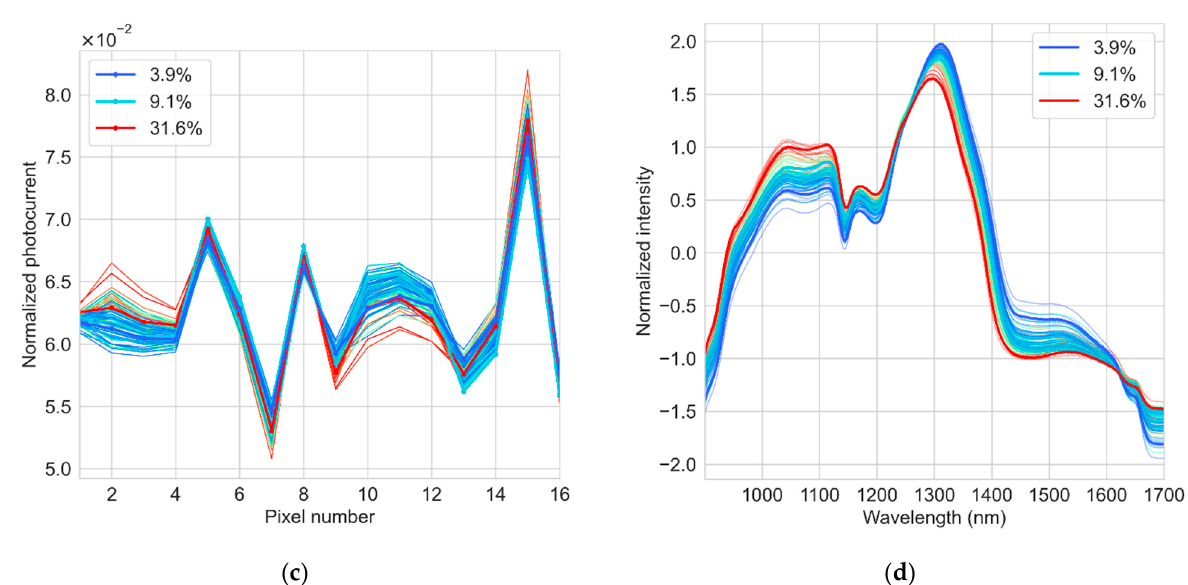
Figure 2. The raw photocurrent and intensity measurements collected using the ( a ) SpectraPod and ( b ) NIRscan, ( c ) the transformation of SpectraPod measurements after normalization by the sum of all spectral points within each measurement and ( d ) the transformation of NIRscan measurements after applying the standard normal variate method. One measurement corresponding to the minimum, median and maximum moisture content is highlighted by the bold line in each plot and their corresponding MC is indicated in the legend.